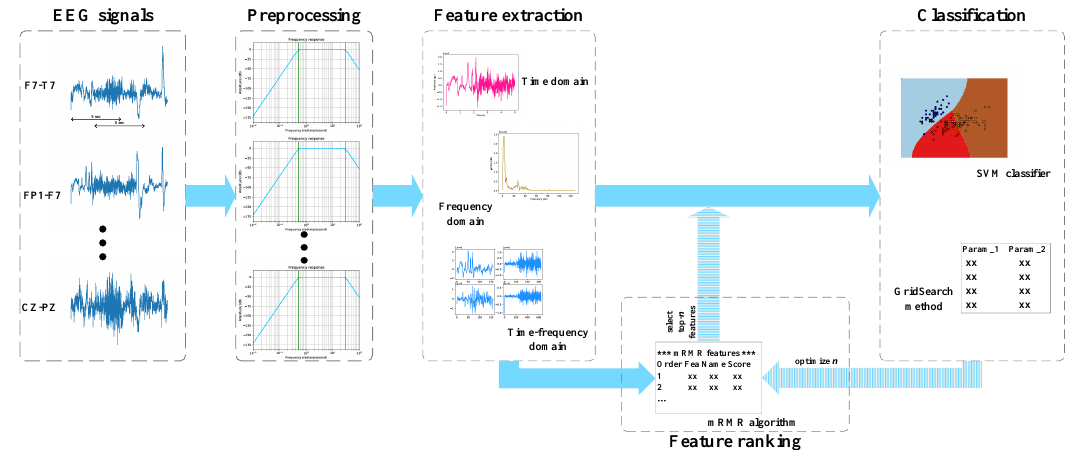
Figure 2. Schematic representation of the proposed framework for seizure